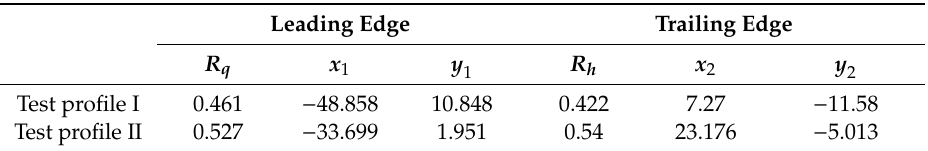
Table 4. Parameters of the leading and trailing edges measured by JE42 (unit: mm).